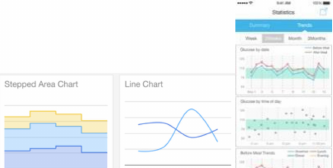
Figure 3. Omron upper-arm sphygmomanometer HEM-7121 and Suunto M1 heart rate monitor.